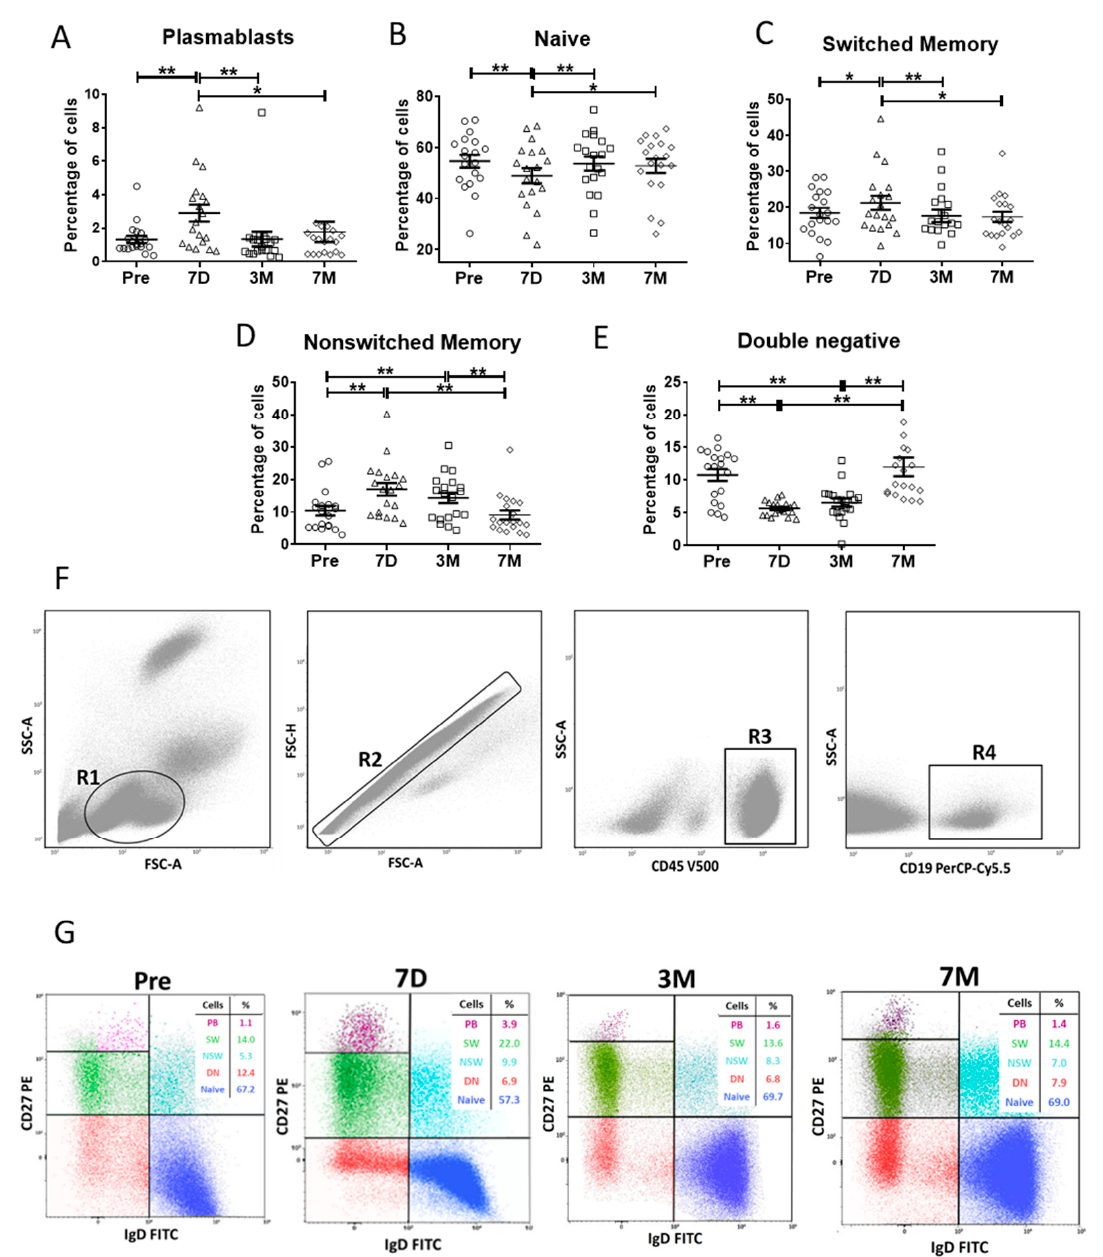
Figure 1. Distribution of B-cell subpopulations. ( A – E ). Percentages of B-cell subpopulations iden- tified by flow cytometry in the gate of CD45+ CD19+ cells before the first dose of the vaccine (Pre) and seven days (7D), three months (3M) and seven months (7M) after the second dose in 19 individuals. Each data point represents one independent sample. The results are expressed as percentages and represent the mean ± SEM. ** p < 0.001, * p < 0.05 Wilcoxon test for paired samples. ( A ). Percentage of PB gated as CD19 low CD20-CD27 high CD38 high (purple). ( B ). Naive B cells gated as CD19+CD20+IgD+CD27- (dark blue). ( C ). SW-MBC gated as CD19+CD20+IgD-CD27+ (green). ( D ). NSW-MBC gated as CD19+CD20+IgD+CD27+ (light blue). ( E ). DN B cells gated as CD19+CD20+IgD- CD27- (red). ( F ). Scheme of gated regions for flow cytometry studies (R1 to R4). ( G ). Representative dot plots from a single experiment are shown. The percentages of each B-cell subpopulation are depicted in the respective tables. DN: double-negative B cells; FSC-A: Forward Scatter-Area; FSC- H: Forward Scatter-Height; NSW-MBC: nonswitched memory B cells; PB: plasmablasts; SEM: stand- ard error mean; SW-MBC: switched memory B cells; SSC-A: Side Scatter-Area.